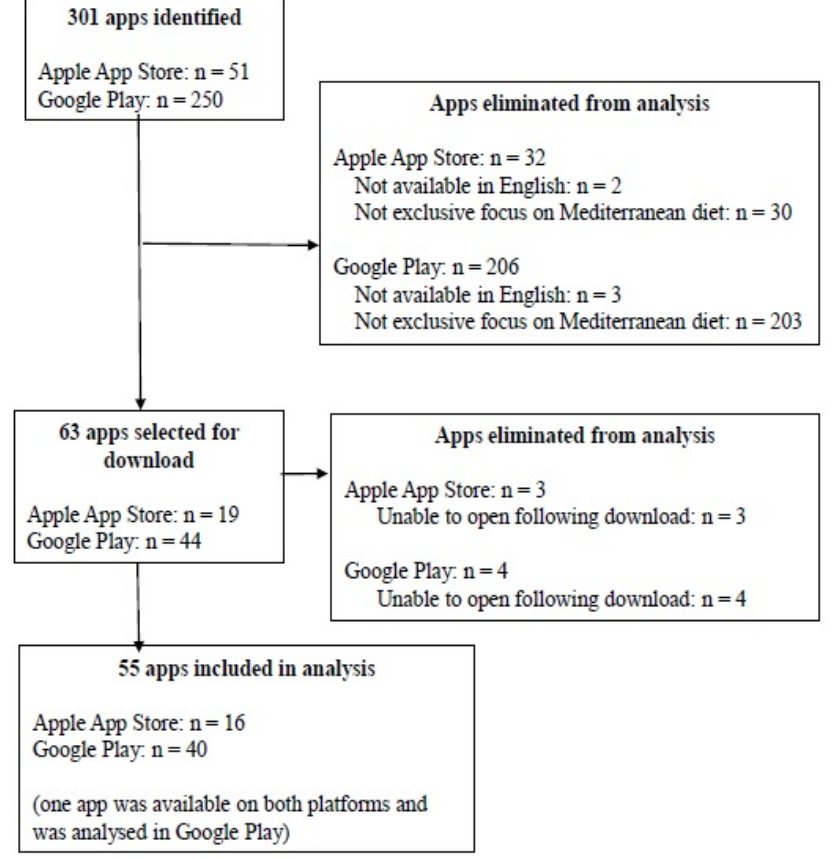
Figure 1. Flow diagram of app search and selection.